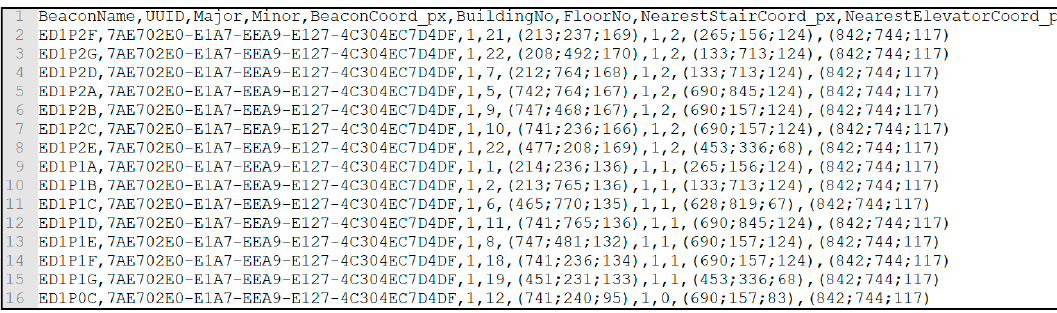
Figure 10. CSV file is containing beacon information.